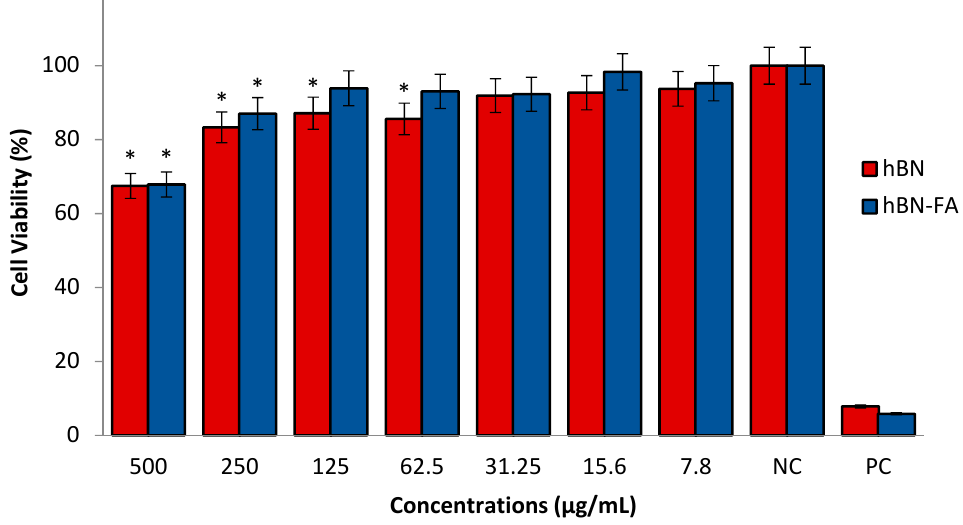
Figure 10. In Vitro cytotoxicity of hBN and hBN-FA on human dermal fibroblast cells (HDFa) for 24 h. Symbol (*) represents a statistically significant difference compared to the negative control.